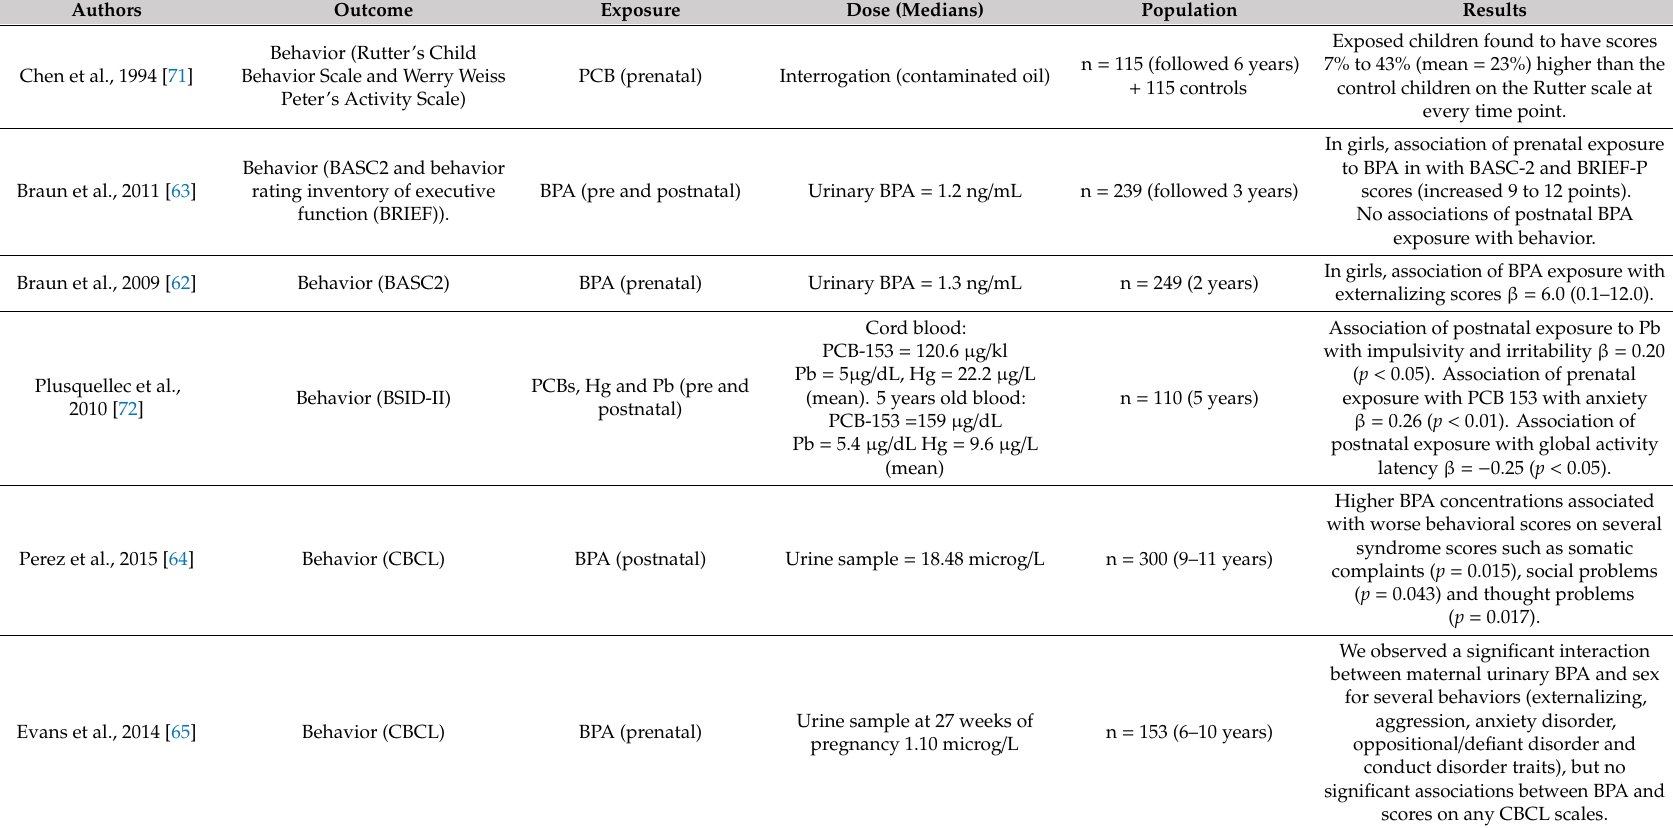
Table 6. Endocrine disruptors and unspecified neurodevelopmental